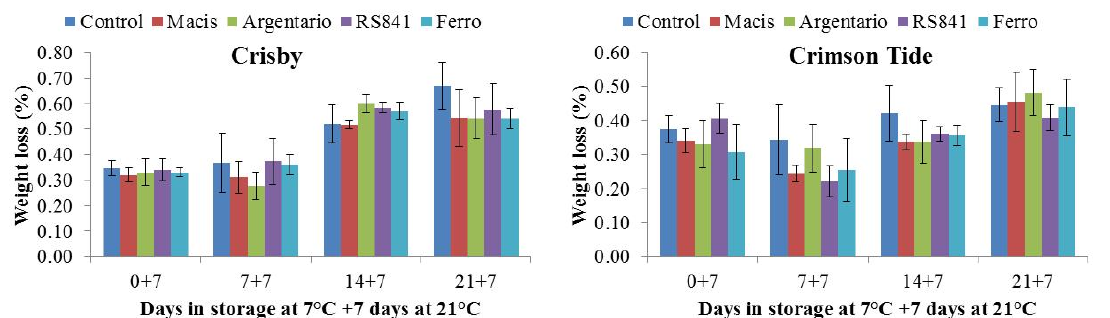
Fig. 2: Effects of rootstocks on weight loss of ‘Crisby’ and ‘Crimson Tide’ watermelon fruits after shelf life period for 7 days at 21 °C following storage at 7